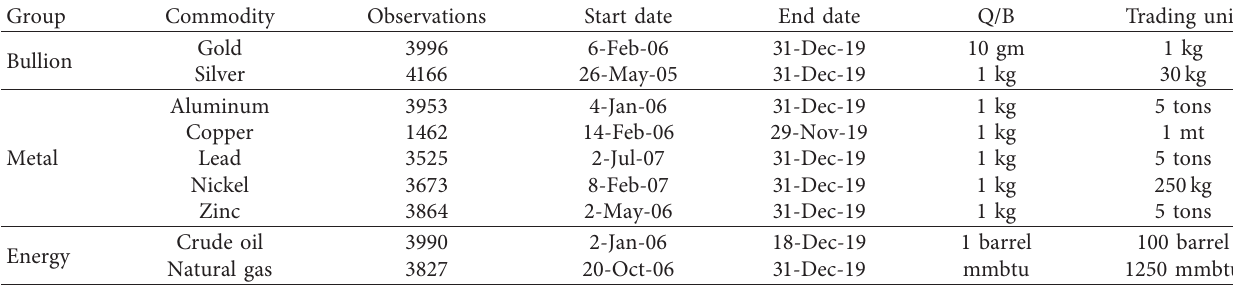
Table 2: Sample details.